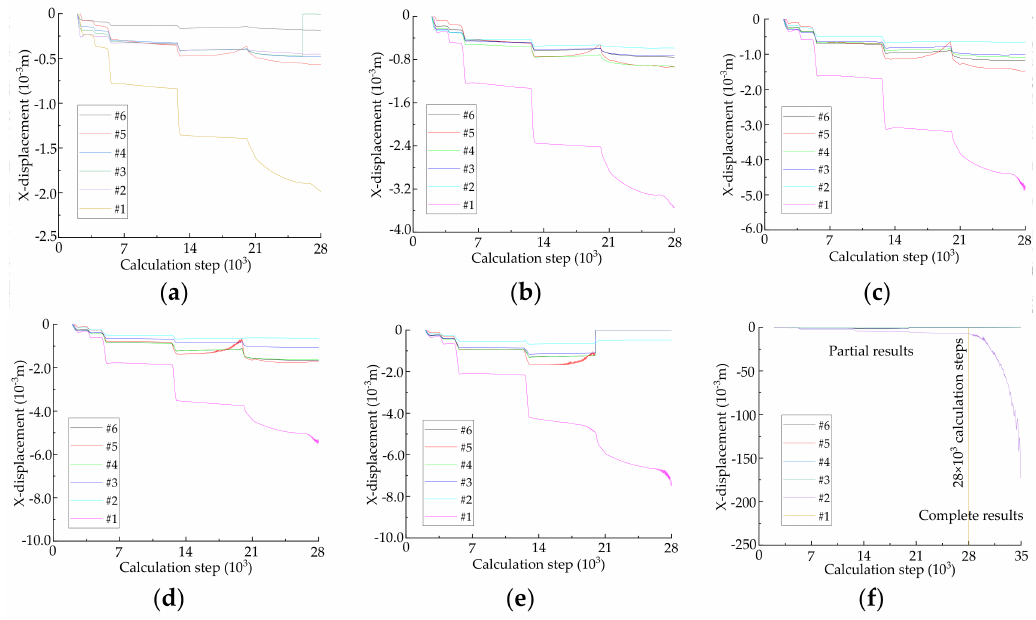
Figure 10. Displacement change of each point in water-resistant strata ahead of karst tunnel face in excavation process. ( a ) The monitoring section of x = − 2; ( b ) The monitoring section of x = − 4; ( c ) The monitoring section of x = − 6; ( d ) The monitoring section of x = − 7; ( e ) The monitoring section of x = − 8; ( f ) The monitoring section of x = − 8.